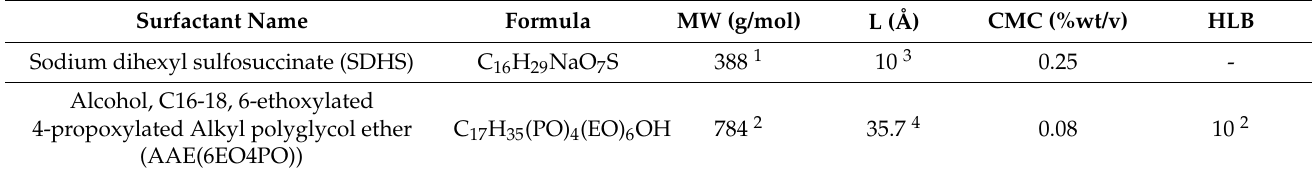
Table 1. Properties of